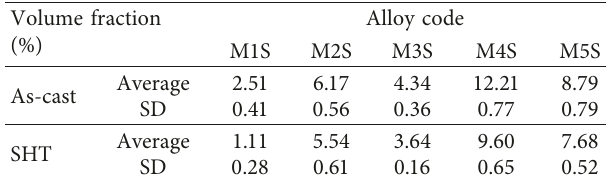
Table 3: Volume fractions (%) of undissolved intermetallic compounds in the matrix of as-cast and as-quenched alloys.